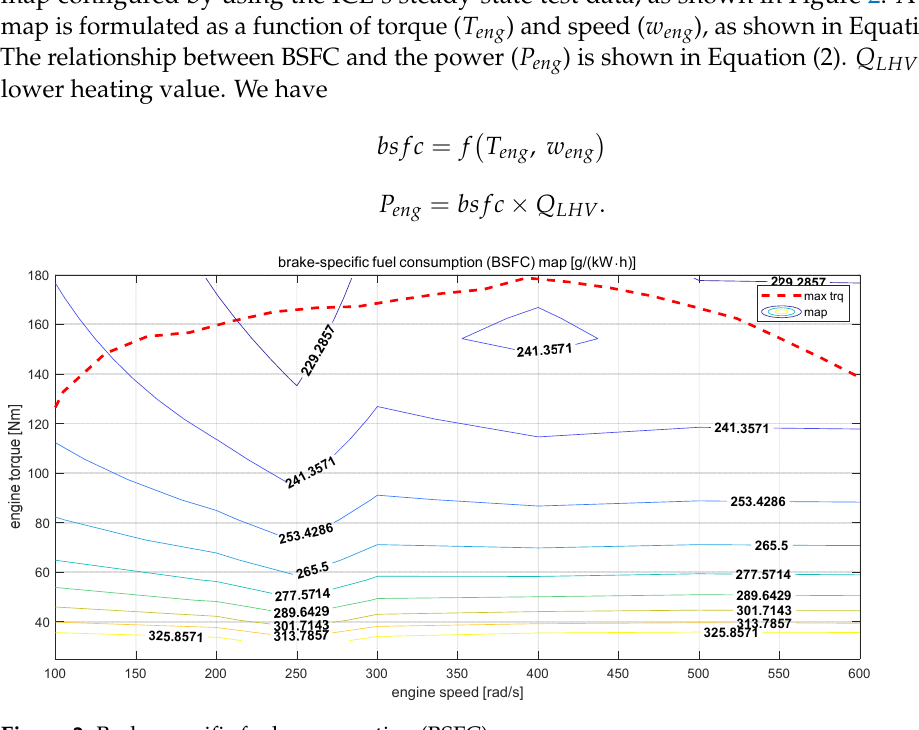
Figure 2. Brake-specific fuel consumption (BSFC) map.